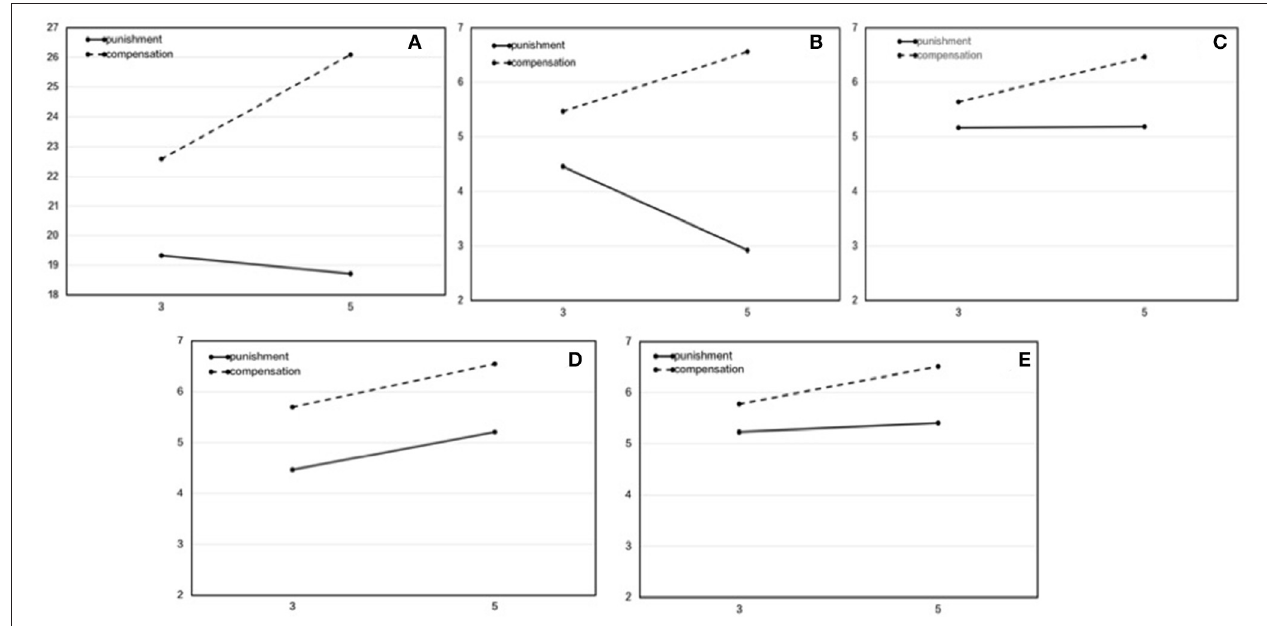
FIGURE 2 | The difference in reputation between punishment and compensation when third parties were free to choose. The horizontal axis is the transfer amount, and the longitudinal axis is the reputational score. (A) Total score. (B) Niceness. (C) Trustworthiness. (D) Group-concernedness. (E) Respectability.